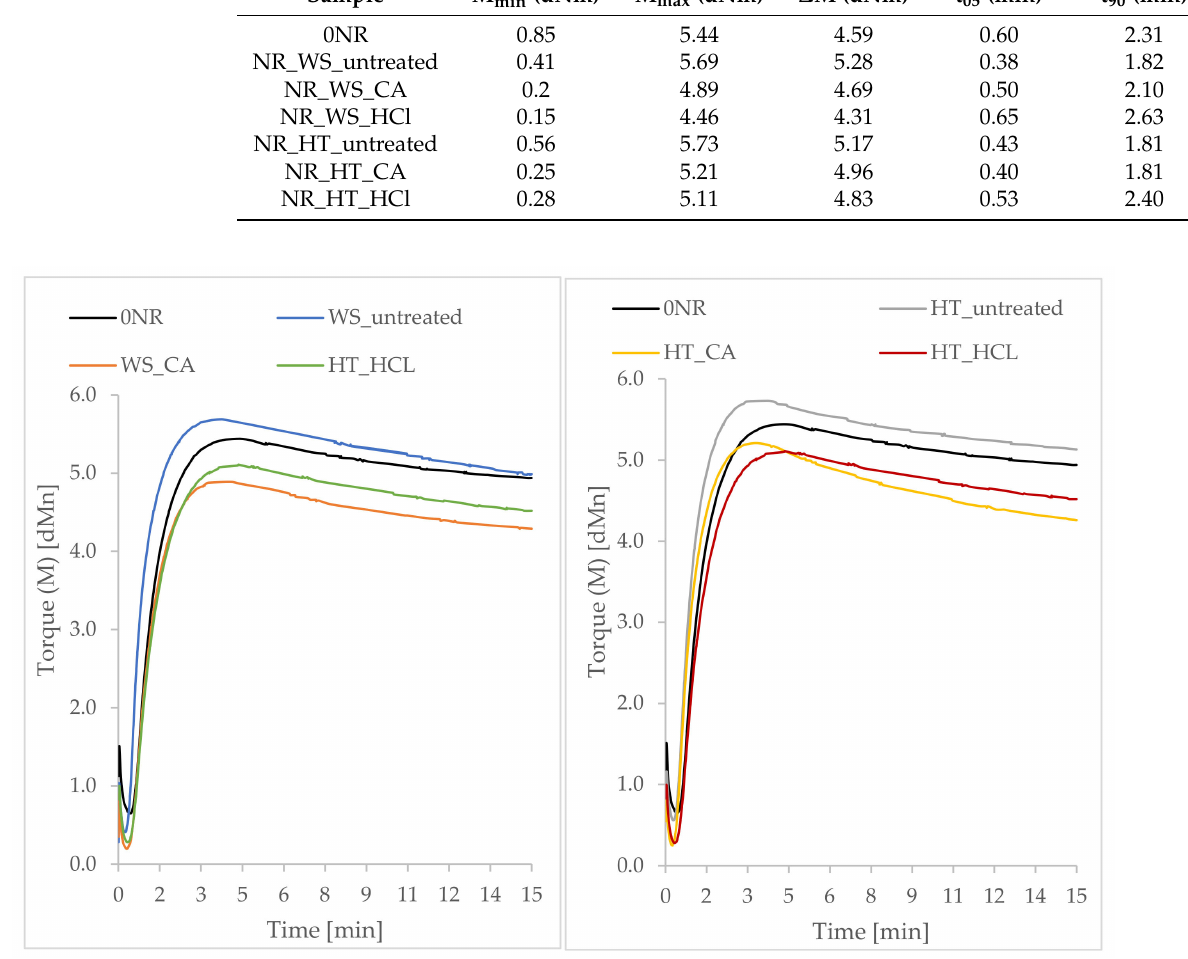
Figure 8. Rheometric curves of rubber